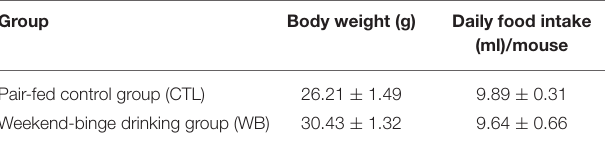
TABLE 1 | Overview of bodyweight and food intake in ApoE − / −